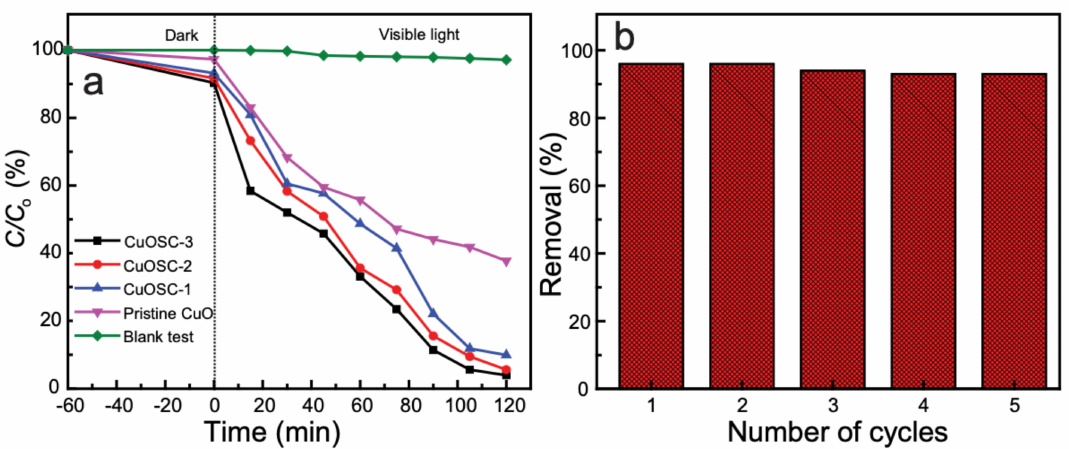
Figure 7. ( a ) Photocatalytic actions of different samples toward an MB solution and the results of a blank test; ( b ) recycling ability of the CuOSC-3